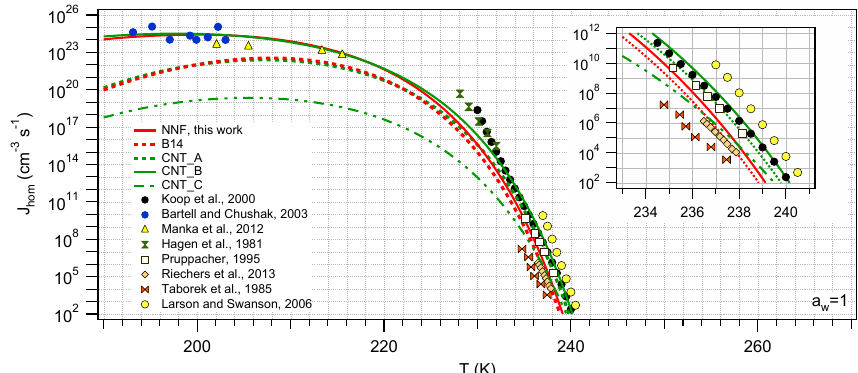
Figure 4. Homogeneous ice nucleation rate calculated using Eq. (16) (labeled “CNT”) and Eq. (11) (labeled “NNF”). For CNT_A (cid:49)G act was defined as in Zobrist et al. (2007), and for CNT_B it was calculated using Eq. (14); in both cases the empirical expression for σ iw from Barahona (2014) was used. For CNT_C the expression of Zobrist et al. (2007) was used for (cid:49)G act and σ iw was calculated using the fit of Reinhardt and Doye (2013). For the model of Koop et al. (2000), a w,eq was defined as in Koop and Zobrist (2009). Also presented are experimental results and empirical formulations obtained from the literature.